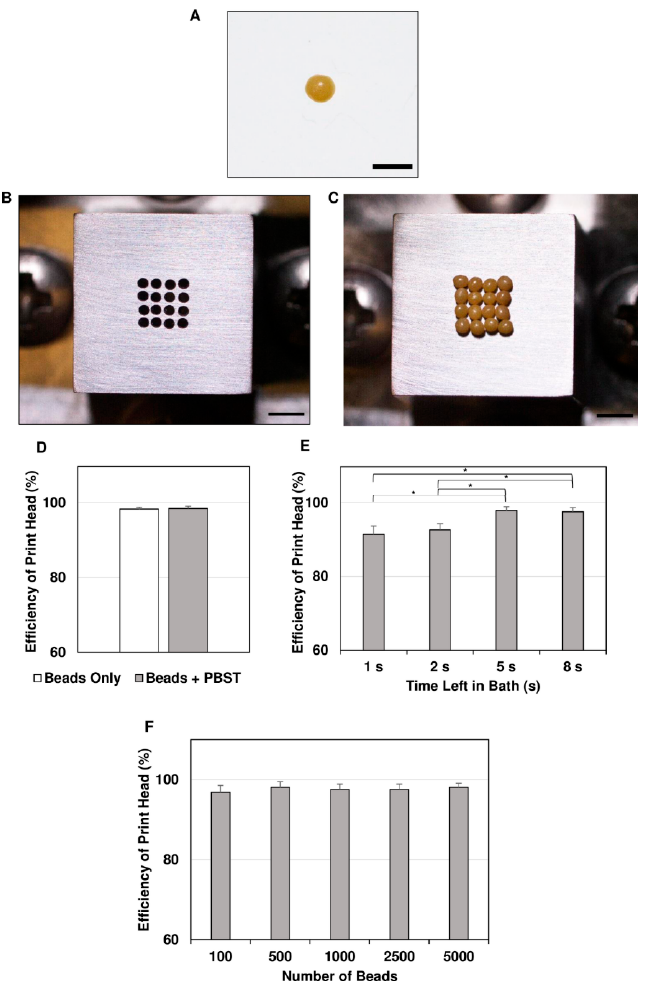
Figure 3. Vacuum and print head capture efficiencies. A substitute was chosen for spheroids